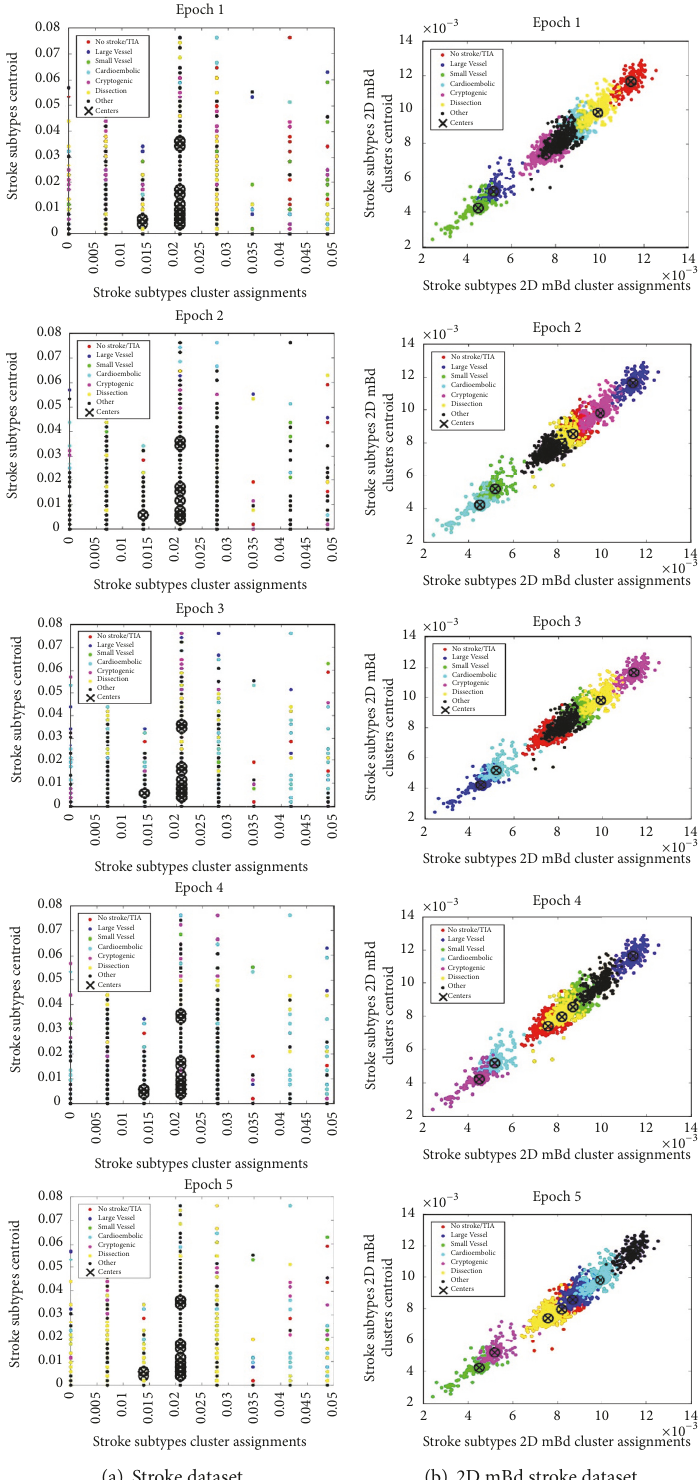
Figure 5: The clustering analyses of 𝐾 -means algorithm based on the